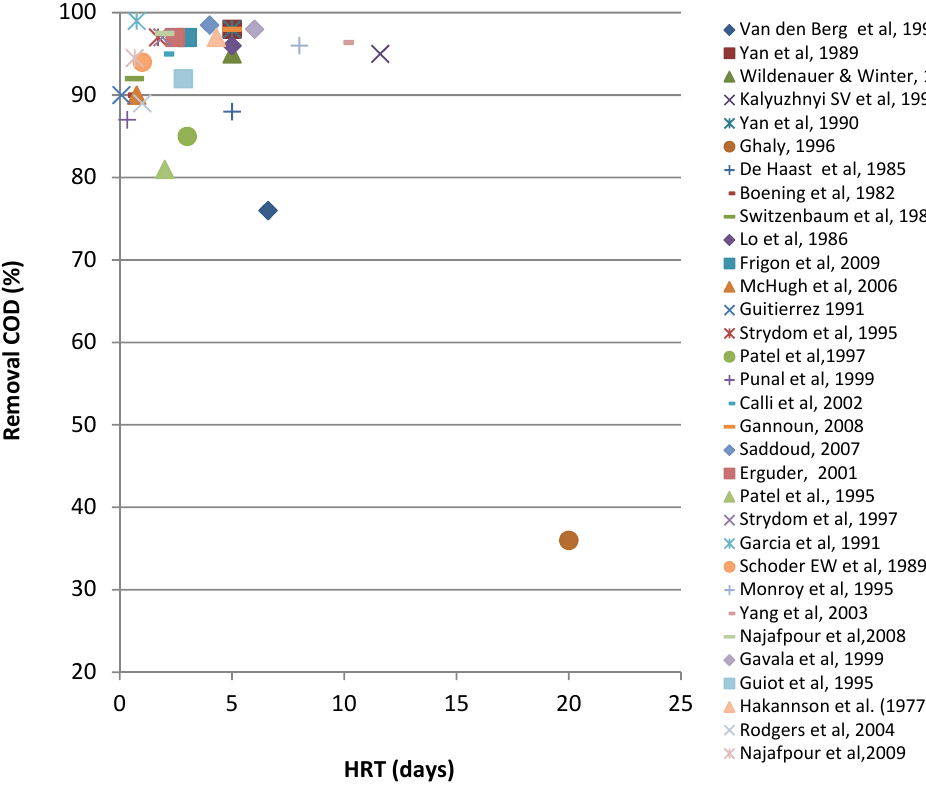
Figure 2. Maximum COD removal (%) versus HRT for various CW treatment